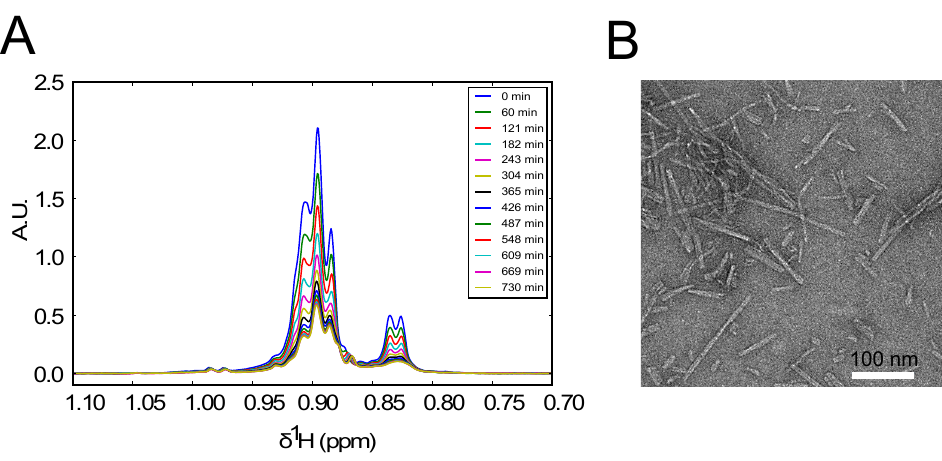
Figure 3. ( A ) Time-dependent proton NMR spectra of the methyl region of the KELCKAVSVSM peptide recorded shortly after addition of 10% dimethyl sulfoxide (DMSO) at 25 °C. The observed decrease of signal intensity is due to the formation of amyloid fibers that are not observed in the spectrum. ( B ) A Transmission Electronic Microscopy (TEM) image of the NMR sample 24 h after the addition of 10% DMSO showing the presence of fibrils of variable length.